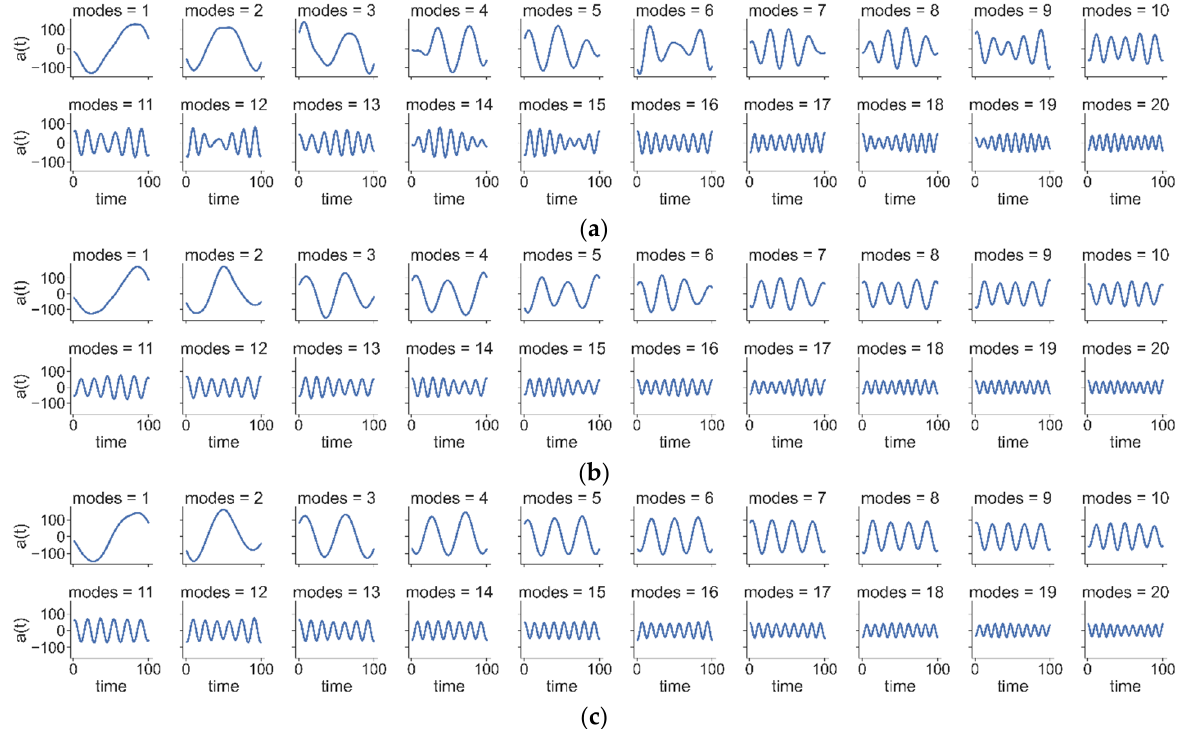
Figure 9. Vortical structures of the first 20 modes behind the MVG with ( a ) Ma 1.5, ( b ) Ma 2.0, ( c ) Ma 2.5.